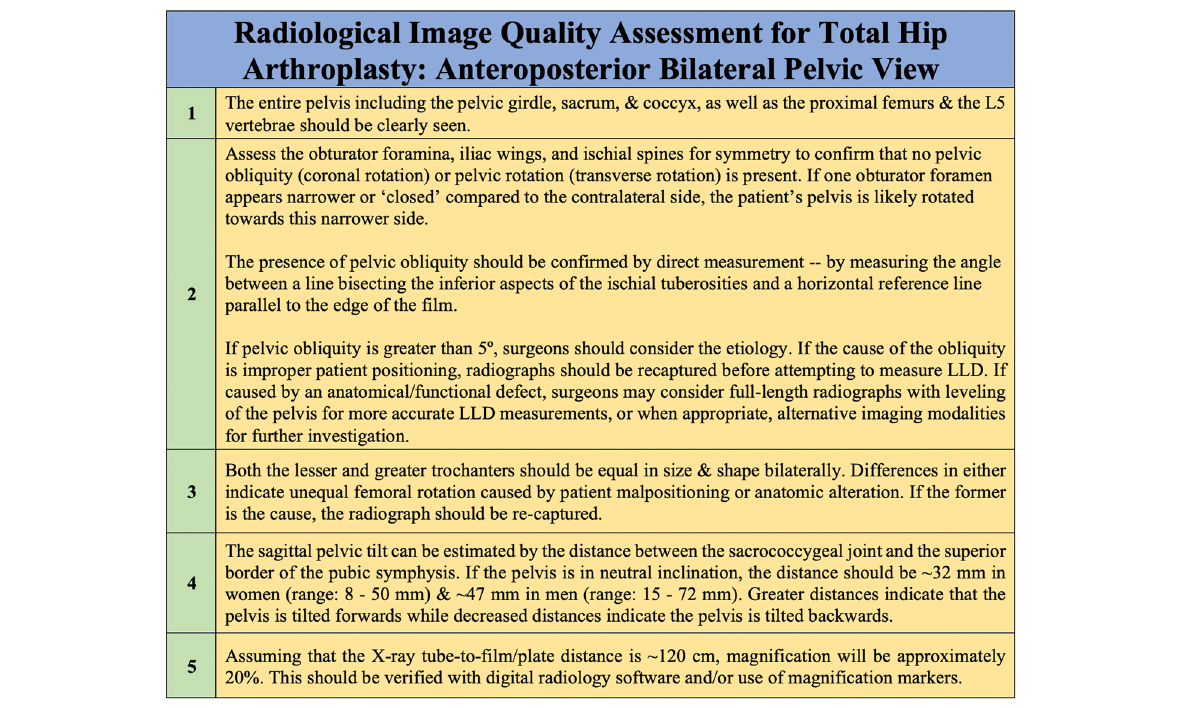
Fig. 9 The significance of properly reviewing radiographs and assessing their quality before carrying our measurements such as LLD cannot be understated. A method for assessing AP pelvic radiographs, including practical considerations for recognizing PO and other postural malalignments is described. The five quintessential radiographic properties outlined in this figure should all be satisfied before deciding to accept a pelvic radiograph as sufficient for producing accurate LLD measurements or for use in preoperative templating for